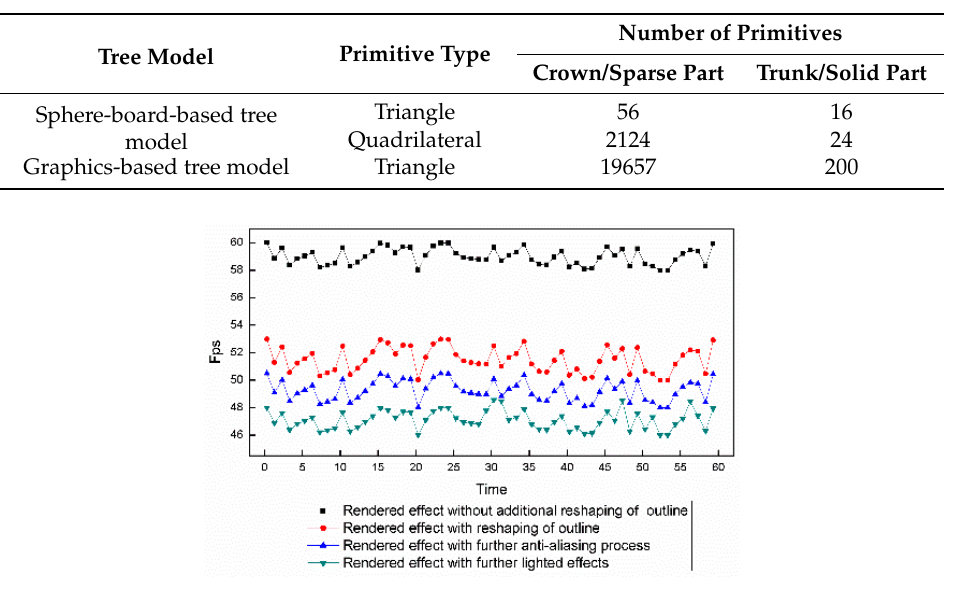
Figure 16. Frame rate curves for the rendering of a single tree model in different scenarios on a 1440 × 810 resolution screen.